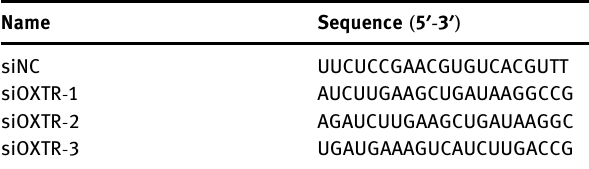
Table 2: The sequences of siRNAs